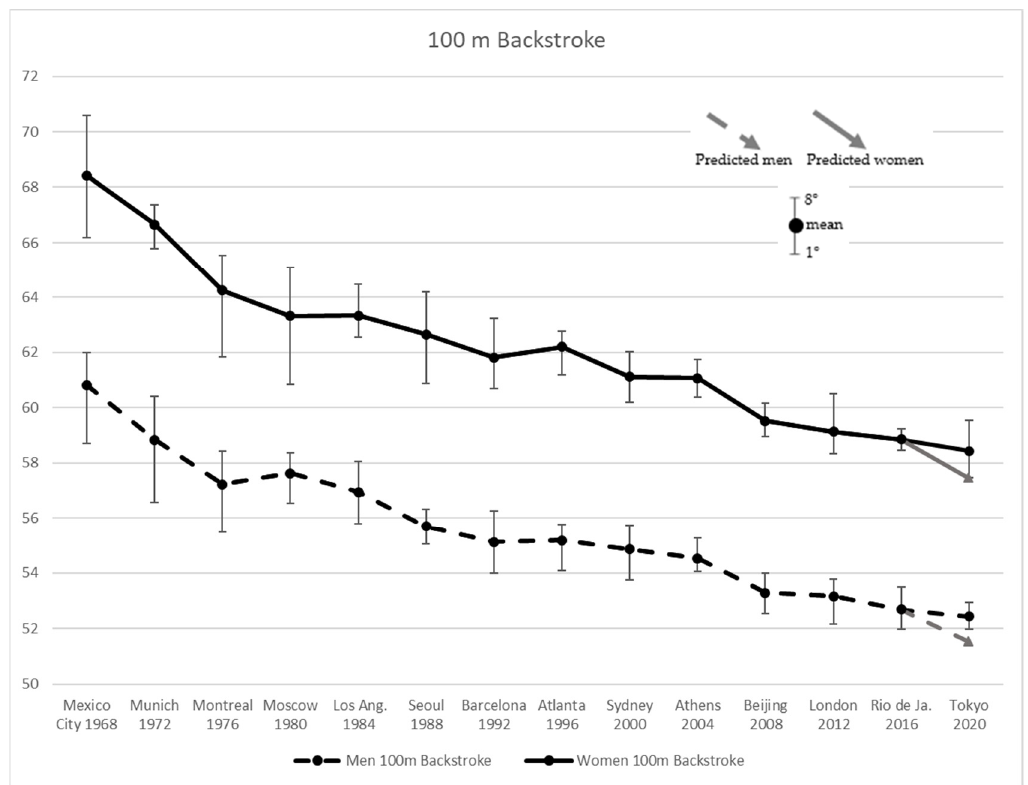
Figure 3. Men’s and Women’s 100 m Backstroke results from Mexico City 1968 to Tokyo 2020 Olympic Games, and the values predicted for the latter.